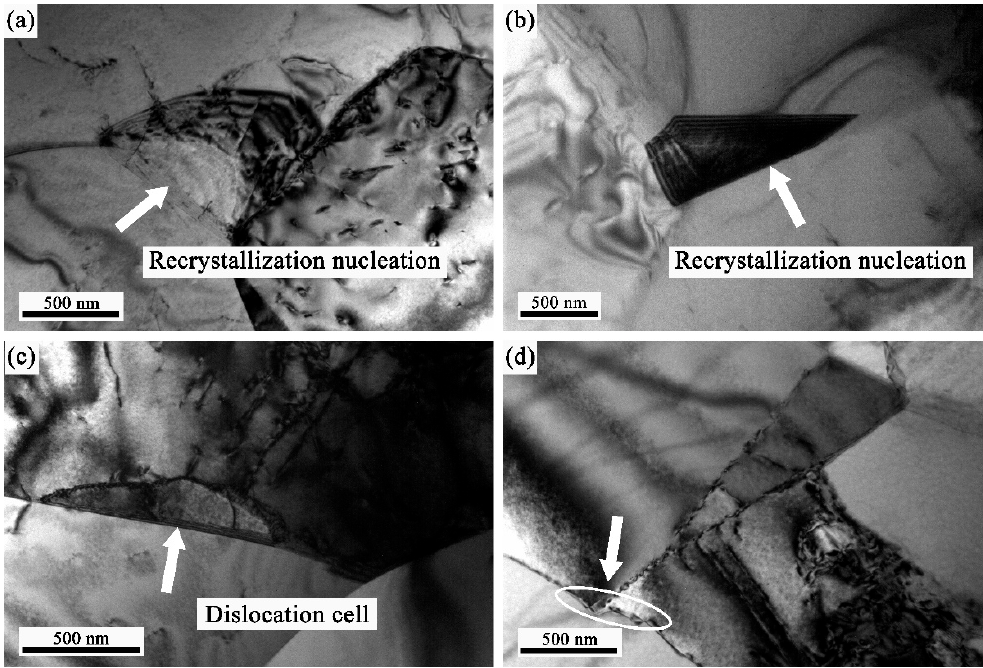
Figure 11. Typical TEM images of the alloy deformed to the ductility of 350.5% at 1080 °C with a strain rate of 1 × 10 − 3 s − 1 : ( a , b ) recrystallization nucleation, ( c ) the dislocation cell formed at grain boundary, ( d ) bands of grain boundaries.